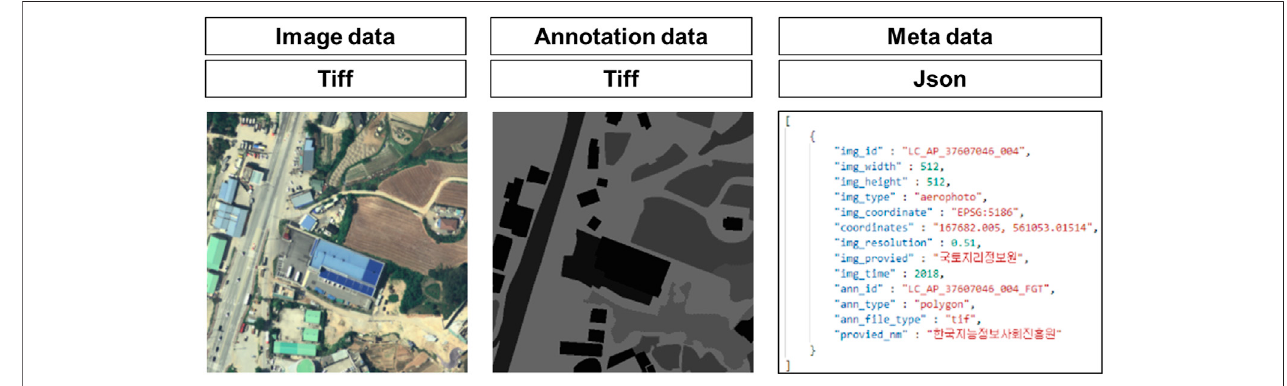
FIGURE 4 | Example of constructed dataset.